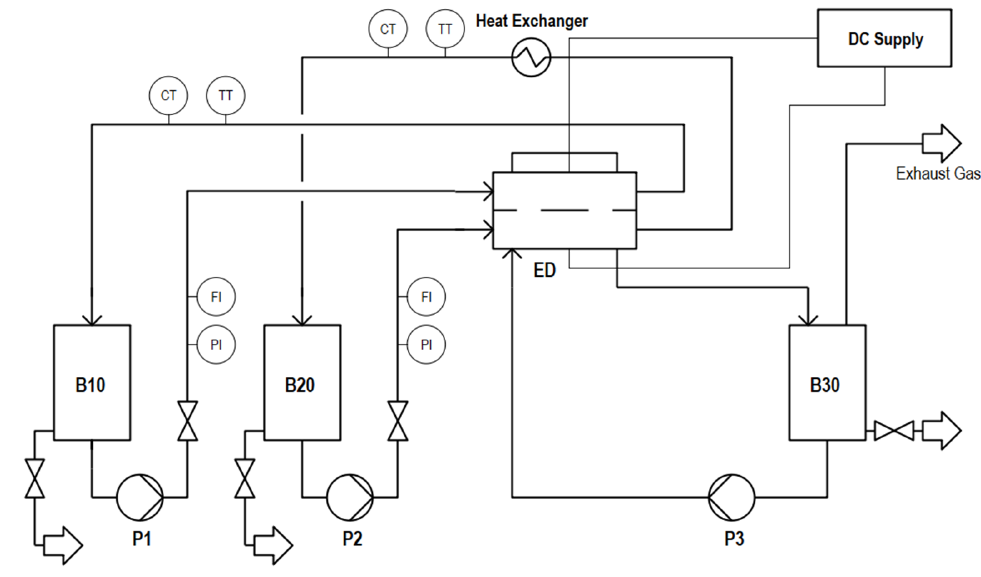
Figure 1. Flow chart of the ED lab plant.